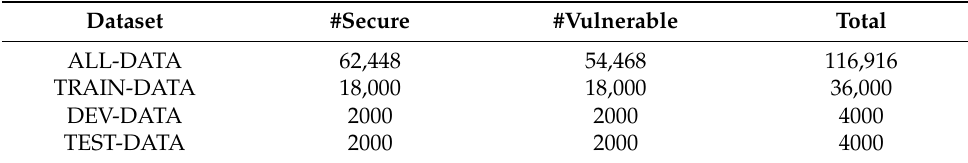
Table 4. Dataset